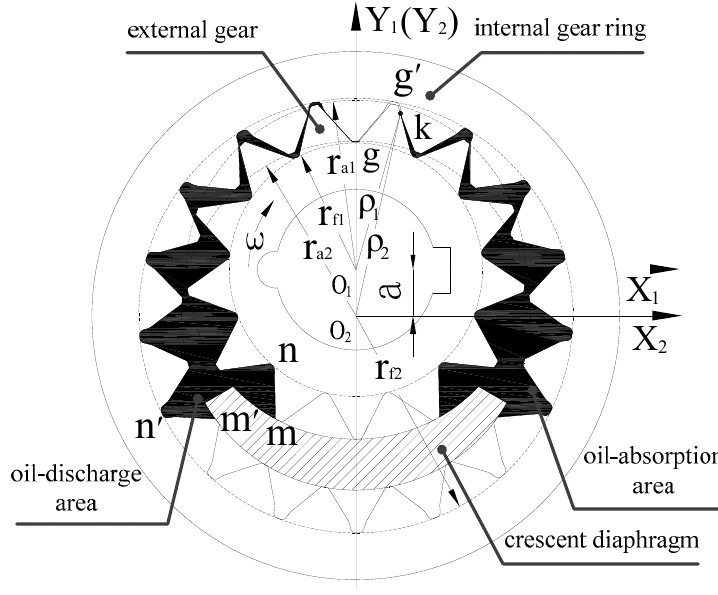
Figure 2. Working dynamic diagram of the straight line conjugate internal meshing gear pump.